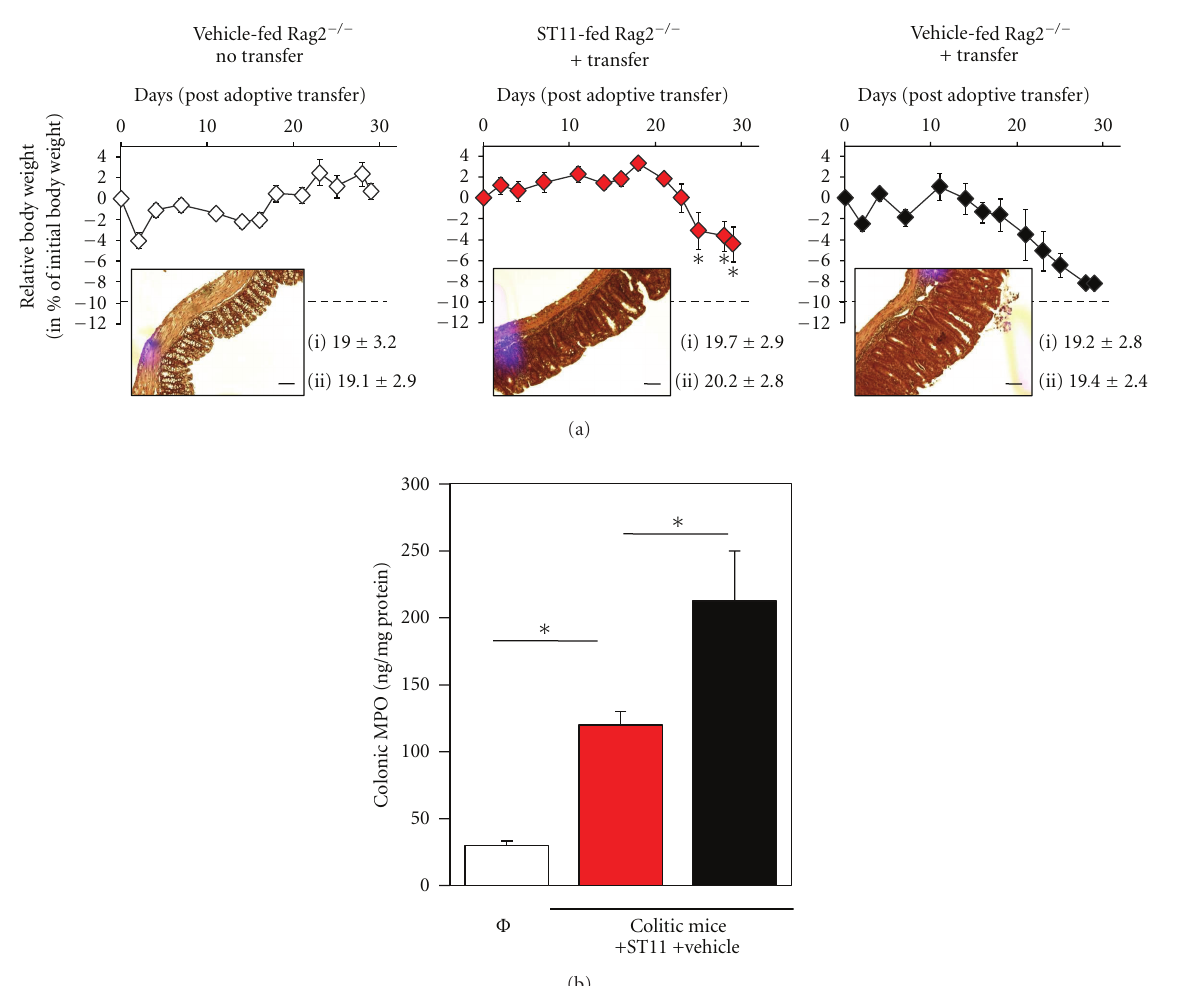
Figure 3: ST11 feeding inhibits colitis development induced by adoptive transfer of na¨ıve T cell in Rag2 − / − mice. (a) 6–8 Rag2 − / − mice either PBS-fed (black diamonds, right graph) or ST11-fed (red diamonds, middle graph) were adoptively transferred with 5 × 10 5 sorted na¨ıve cells. Recipient mice were weighted 3 times a week. As negative control, a group of nontransferred Rag2 − / − mice was used (empty diamond, left graph). Weight changes (in % of initial body weight) of control or recipient mice ± SD are shown. Average weight in grams ± SD at the enrollment (i) and at day 0 before colitis induction (ii) is given for each group below the graphs. 4 weeks after cell transfer, mice were sacrificed and assessed for histopathology. Inserts are representative H&E stained pictures of colon sections; black bar represents 50 μ m (magnification × 20). (b) Colonic MPO was assessed in every single mouse by ELISA and expressed in ng MPO per mg of total colonic proteins. Student’s t -test with t , tendency P < 0 . 1; ∗ , P < 0 . 05, and ∗∗ P < 0 . 01 versus PBS-fed